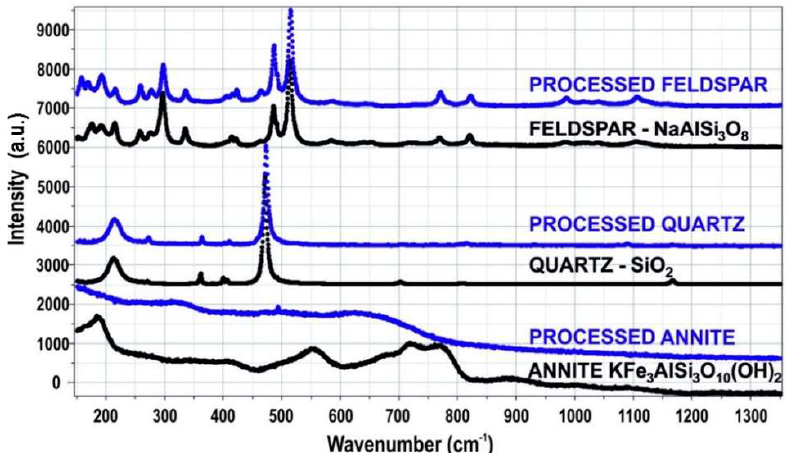
Figure 6. Raman spectrum for the different phases distinguished in the black granite prior and after the laser blasting process.